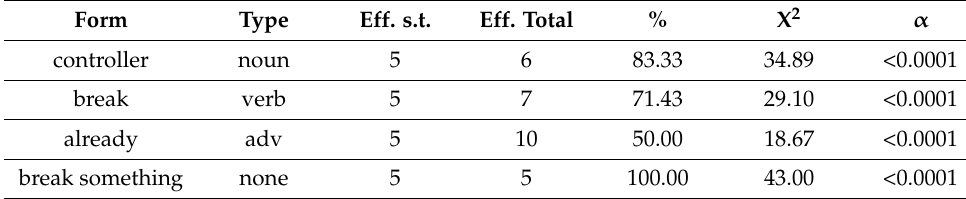
Table 1. More frequent words in class 2: Break something.